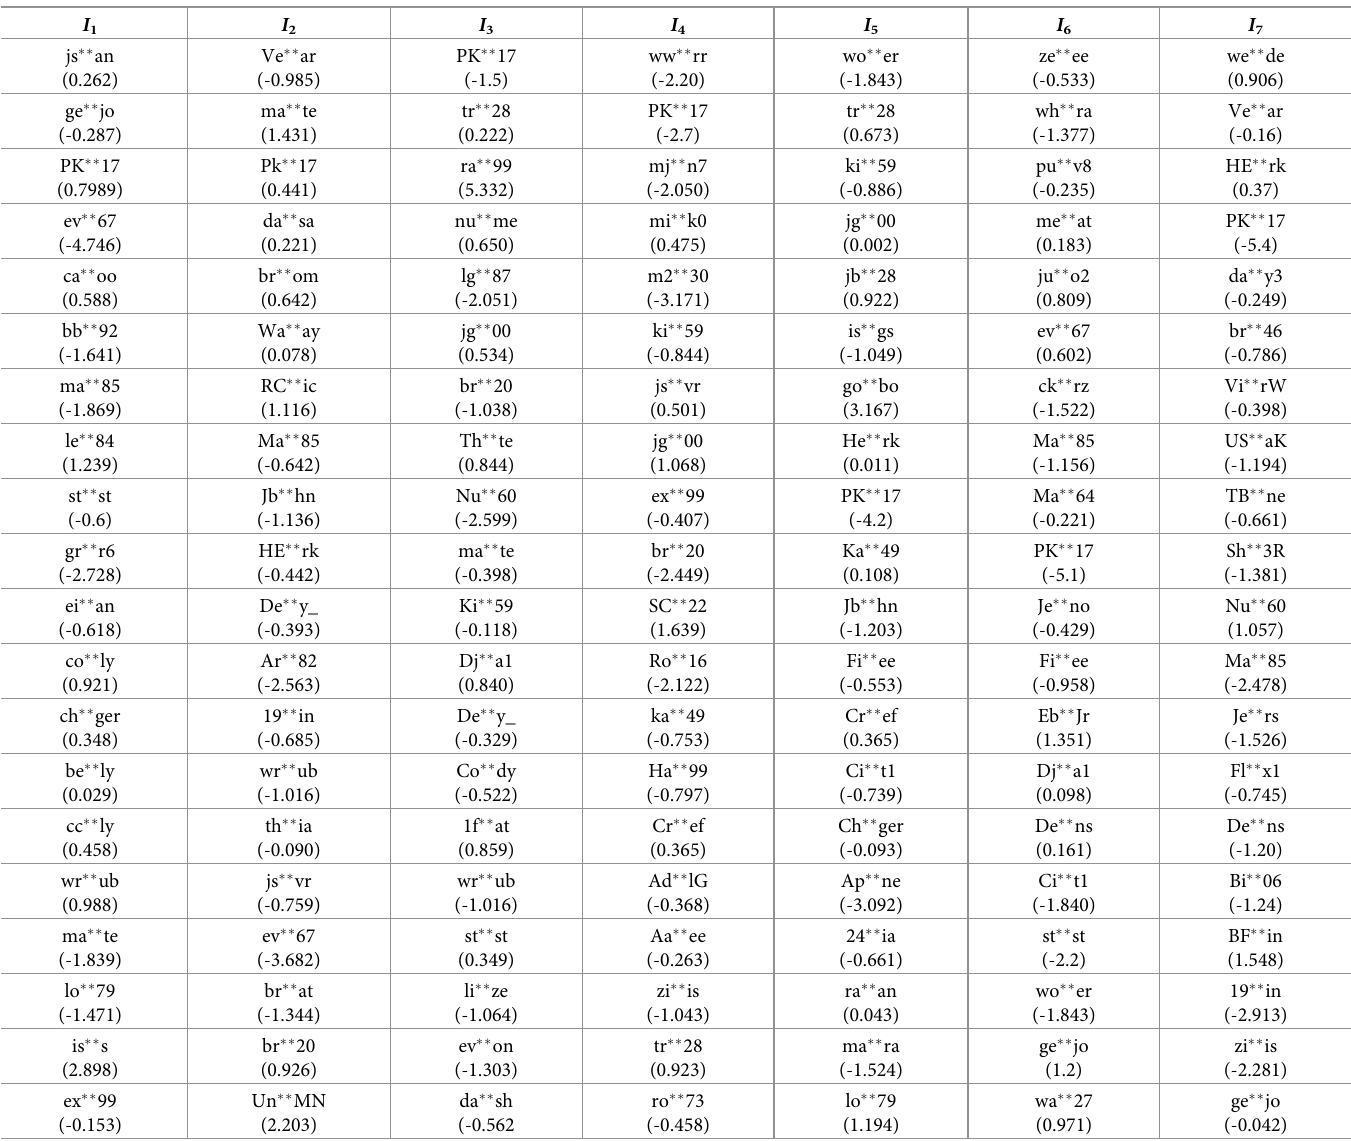
Table 5. Top 20 active users with their overall